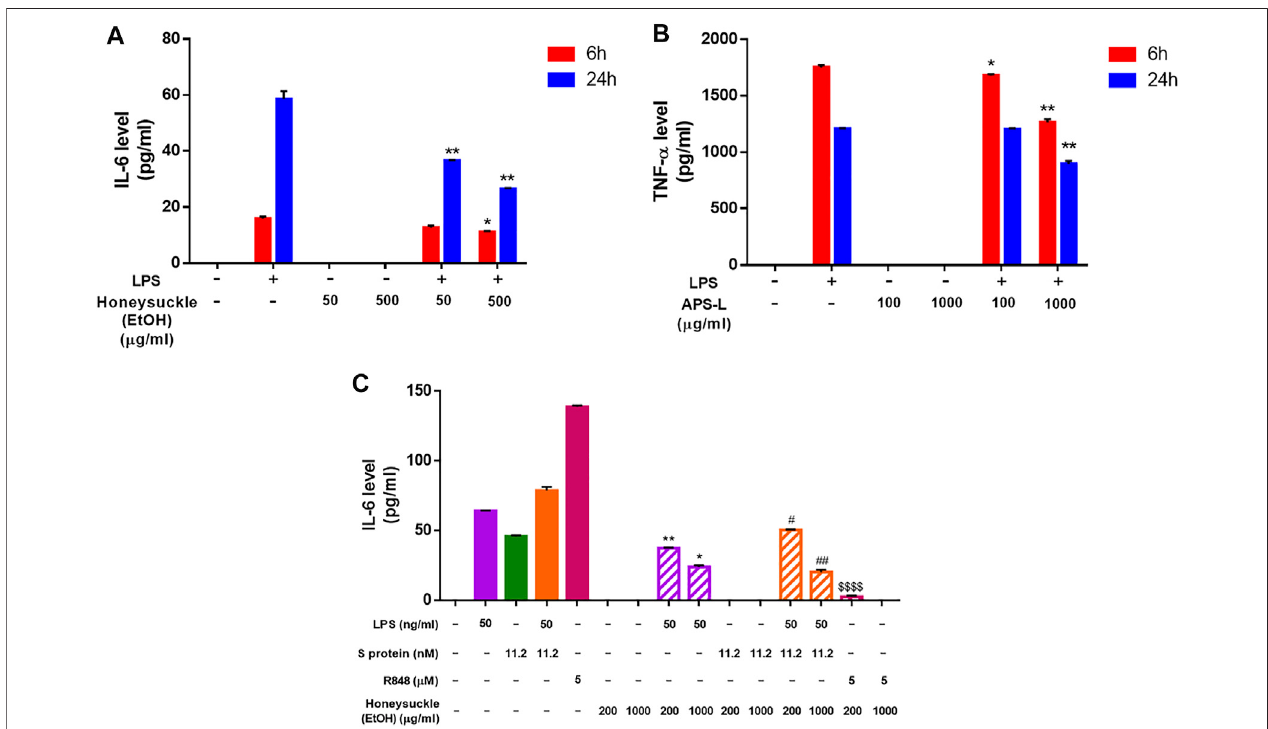
FIGURE5| InhibitionofcytokinereleaselevelbytheTCMcandidates.After6and24hofhoneysuckle-EtOH (A) orAPS-L (B) treatmentinthepresenceorabsence ofLPS,THP-1cellmediumwascollected,andELISAwasperformedtomeasurecytokinelevels.TreatmentwithLPSalonewasconsideredtobethecontrol. (C) After24 h of honeysuckle-EtOH treatment in the presence or absence of stimulators (LPS, Spike, LPS + Spike, and R848), THP-1 cell medium was collected, and ELISA was performed to measure IL-6 levels. Data are expressed as mean ± SD from three repeated results and analyzed using Student ’ s t-test. * compared to LPS stimulation alone, # compared to combined stimulation of LPS and Spike, and $ compared to R848 stimulation alone. *, signi fi cantly different from the corresponding control, at p < 0.05; **, p < 0.01. Similar for # and $ .